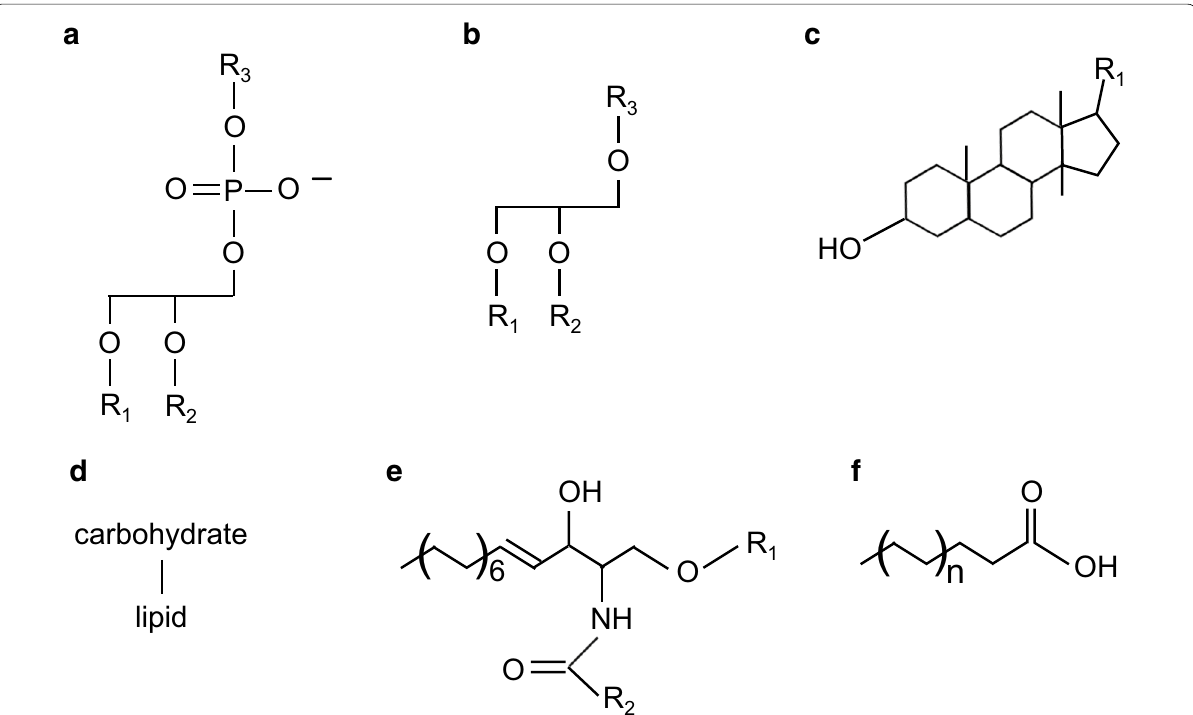
Fig. 1 Schematic representation of the six different classes of lipids. a Glycerophospholipid. R 1 represents a fatty acyl or alkyl groups. R 2 and R 3 depict a fatty acyl group and a polar group, respectively. b Glycerolipid. R 1 represents a fatty acid while R 2 and R 3 can be a fatty acid or a hydroxyl group. c Steroid based lipid. d Glycolipid. The lipid anchor can be a glycerophospholipid or a sphingolipid. e Sphingolipid. R 1 and R 2 represent a polar group and a fatty acyl group, respectively. f Free fatty